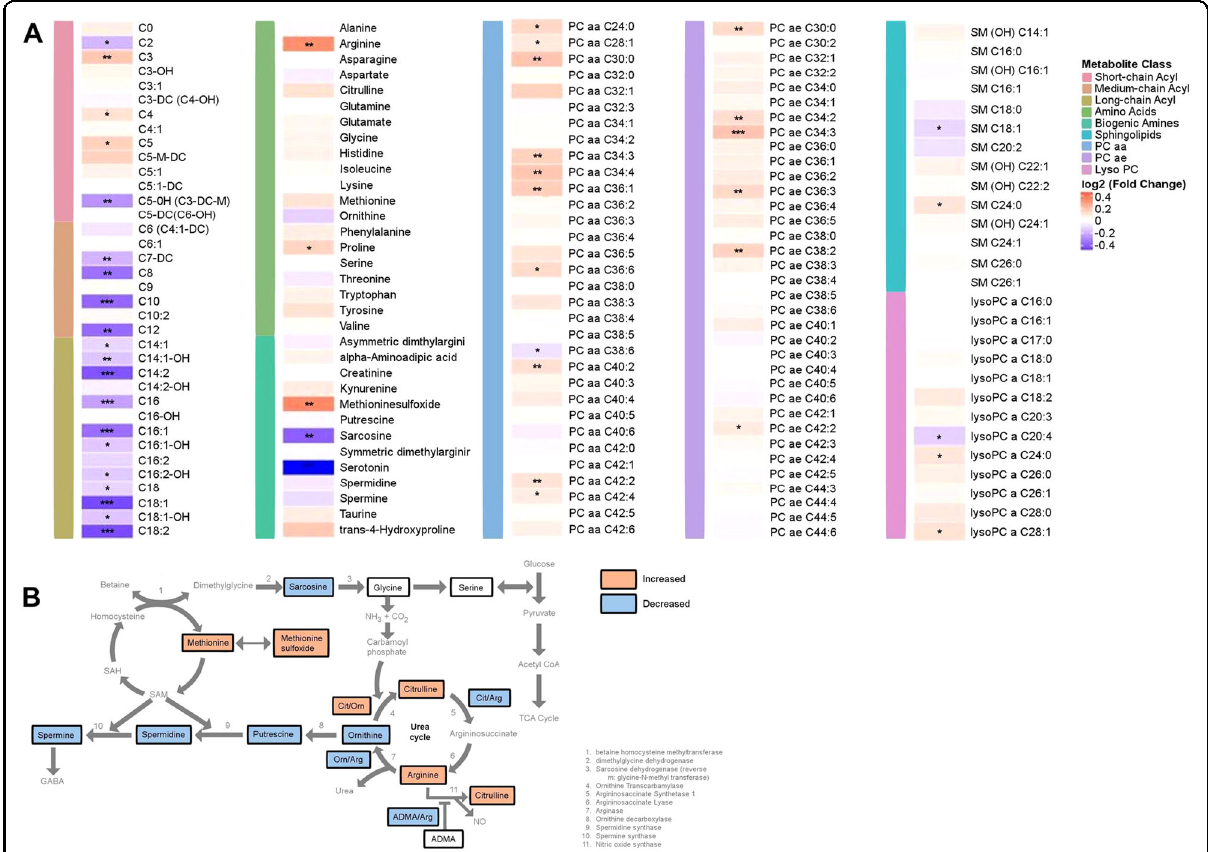
Fig. 2 Change in metabolite levels from pre-treatment to 8 weeks post-treatment with escitalopram/citalopram. A Heatmap depicting log2- fold changes in metabolite levels. P values were obtained using linear mixed-effect models controlling for age, sex, and baseline HRSD 17 were corrected for multiple comparisons. Red indicates an increase and blue indicates a decrease in metabolite levels over 8 weeks of treatment; * q -value < 0.05, ** q -value < 0.01, and *** q -value < 0.001. PC phosphatidylcholine, SM sphingomyelin, LysoPC lysophosphatidylcholine, SSRI selective serotonin reuptake inhibitor, HRSD 17 17-item Hamilton Rating Scale for Depression. Metabolite abbreviations are spelled out in Supplementary Table 1. B Effect of SSRI on interconnected pathways, including polyamine, sarcosine, urea cycle, and 1-carbon metabolism. Orange boxes indicate an increase in metabolite levels, while blue boxes represent a decrease in metabolite levels. White boxes represent no change in in metabolite levels. Metabolites not measured in this assay are in gray. NH 3 ammonia, CO 2 carbon dioxide, SAH S-adenosyl-l-homocysteine, SAM S-adenosyl methionine, Cit citrulline, Orn ornithine, Arg arginine, ADMA asymmetric dimethylarginine, CoA coenzyme